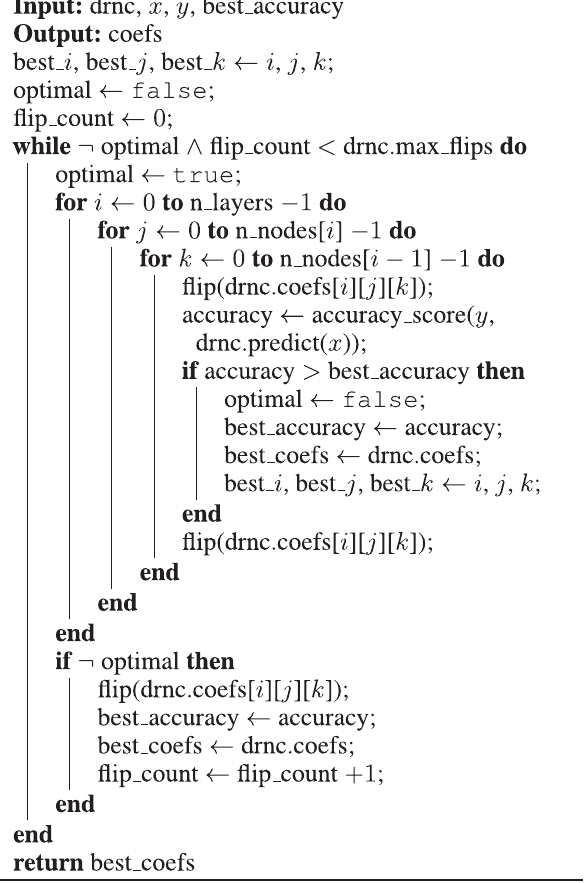
Algorithm 2. Deep Rule Network Training, optimize_coefs()- method